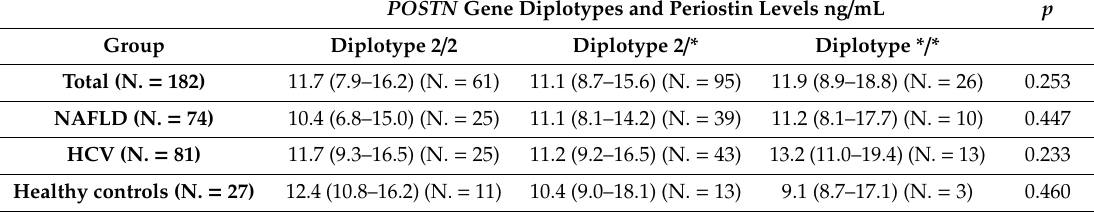
Table 8. Plasma periostin values as a function of the POSTN gene diplotypes. * = any other haplotype di ff erent from haplotype 2. Median and interquartile range are reported. The p value refers to the di ff erences of periostin plasma levels between the various POSTN diplotypes.